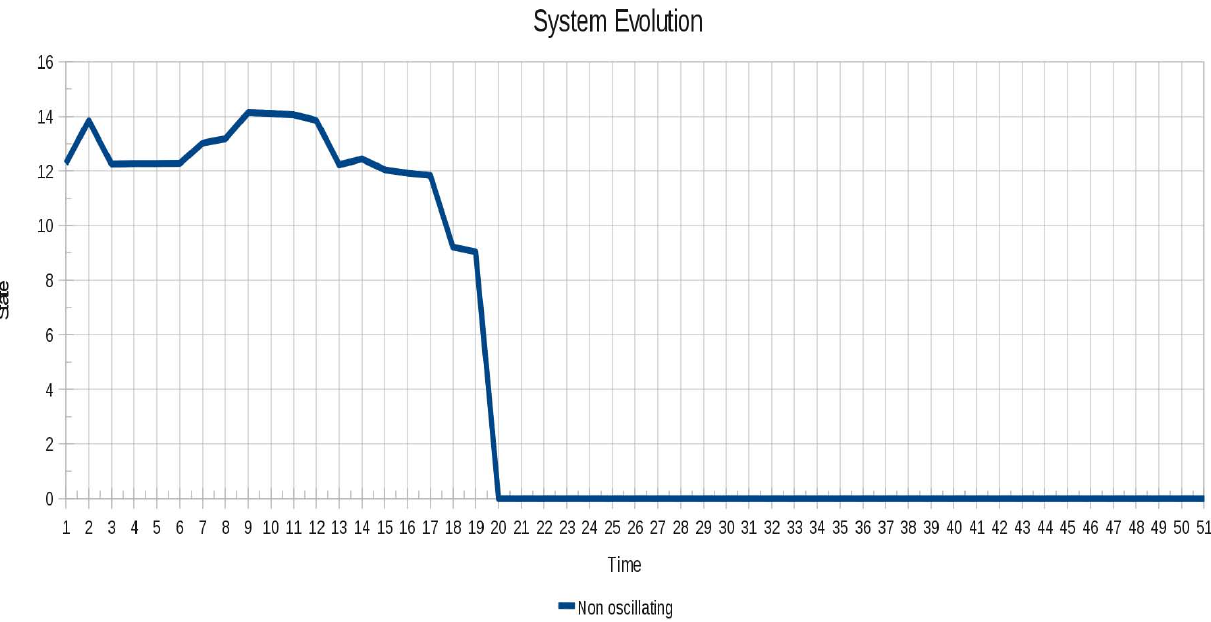
Figure 8. Behavior of the instance 2 (Non-oscillating).